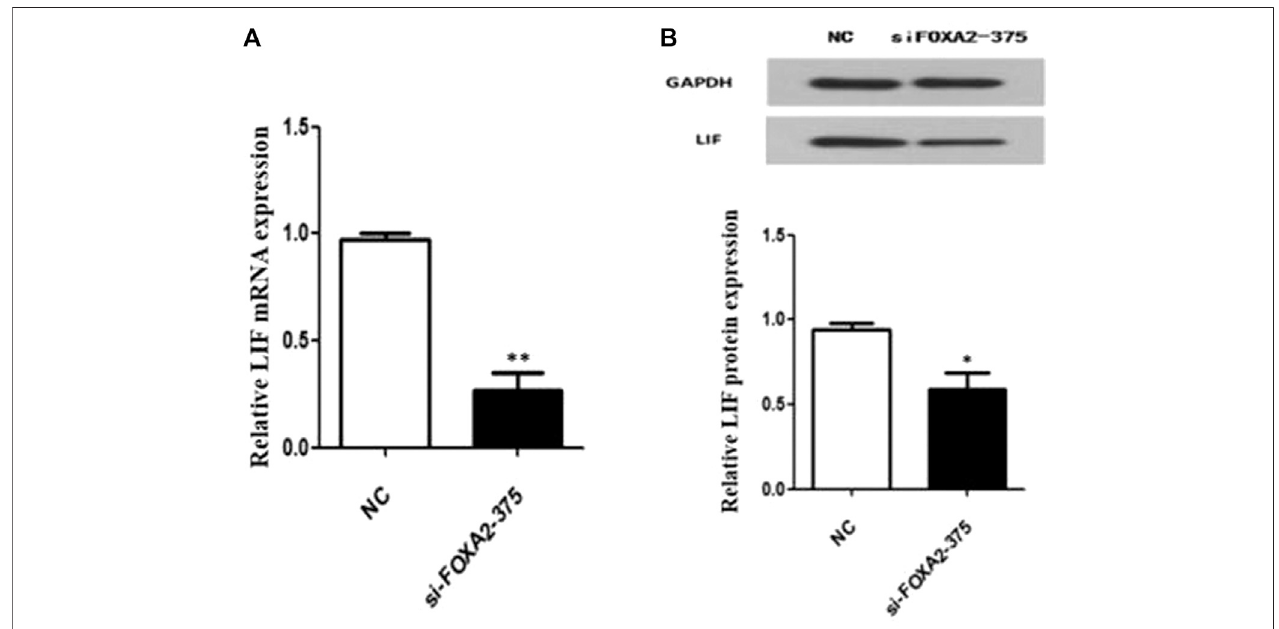
FIGURE 3 | Expression of LIF in HEK 293T cells with FOXA2 knockdown. (A) The mRNA level of LIF was measured by qPCR. (B) The protein level of LIF was detected by western blot. Student ’ s t-test was used for the p value analysis. * p < 0.05; ** p < 0.01.